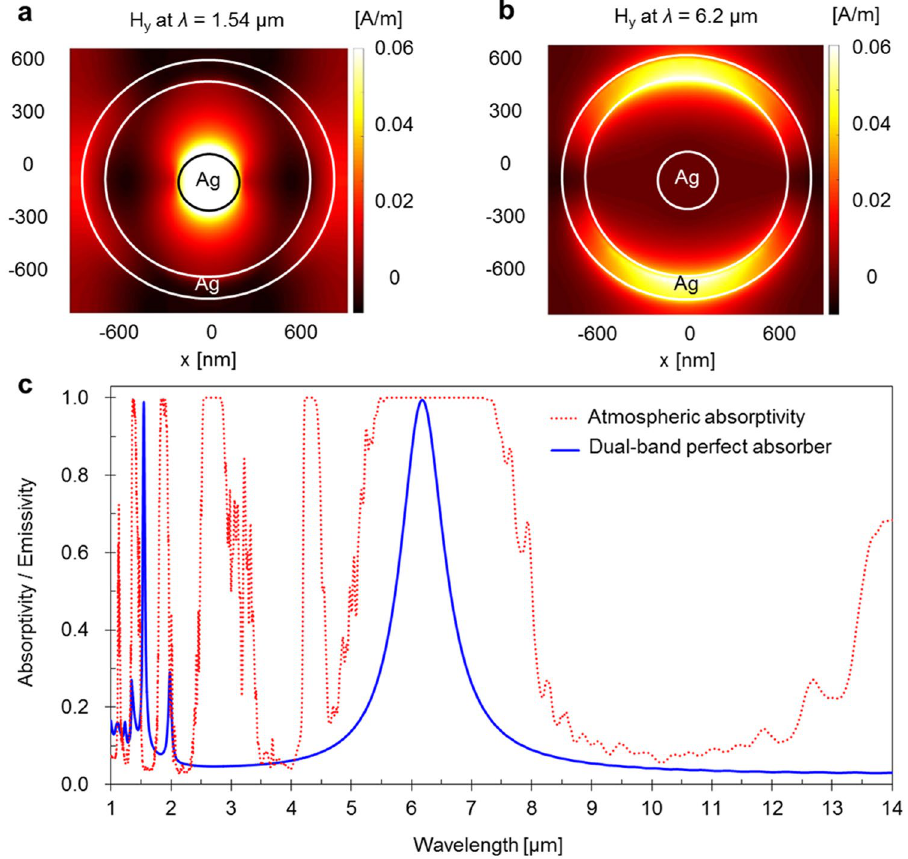
Figure 4. Magnetic field distributions and spectral properties. ( a ) and ( b ) Top views of the magnetic field distributions of the MPs calculated at 1.54 μ m and 6.2 μ m, respectively. ( c ) Spectral properties of the dual-band perfect absorber proposed in this work (solid line) and the atmospheric absorption spectrum (dotted line).